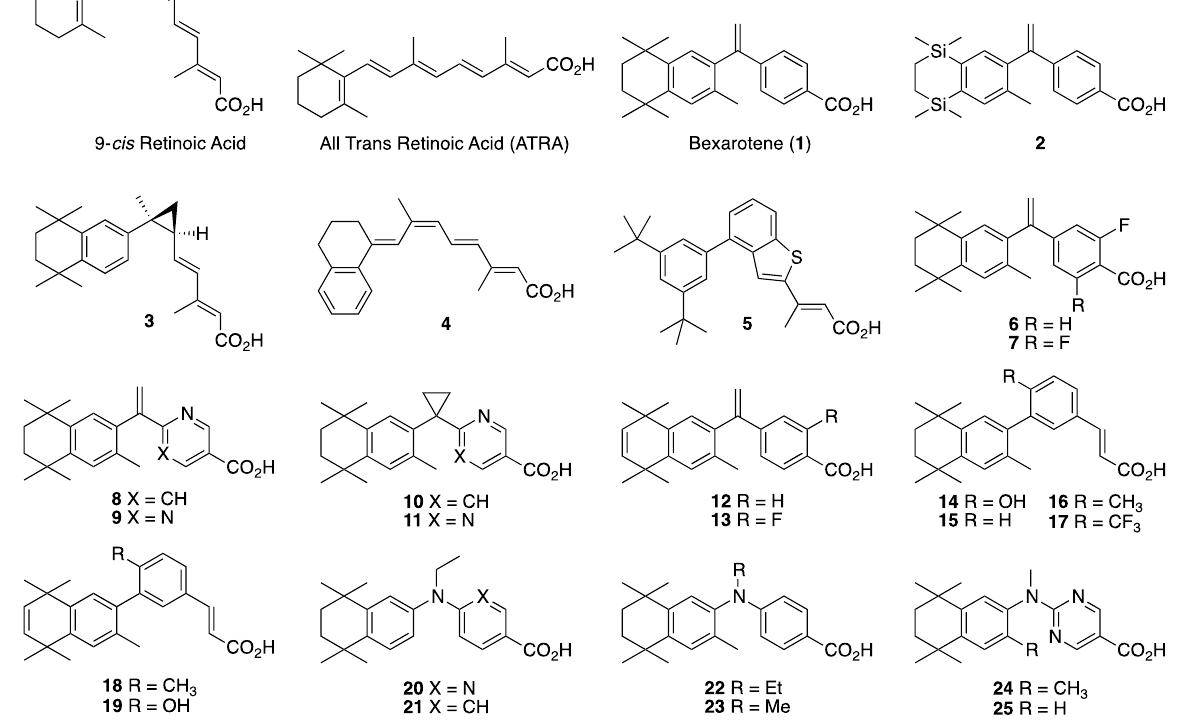
Figure 1. Structures of 9- cis Retinoic Acid, ATRA, Bexarotene ( 1 ), and Rexinoids 2–25 .